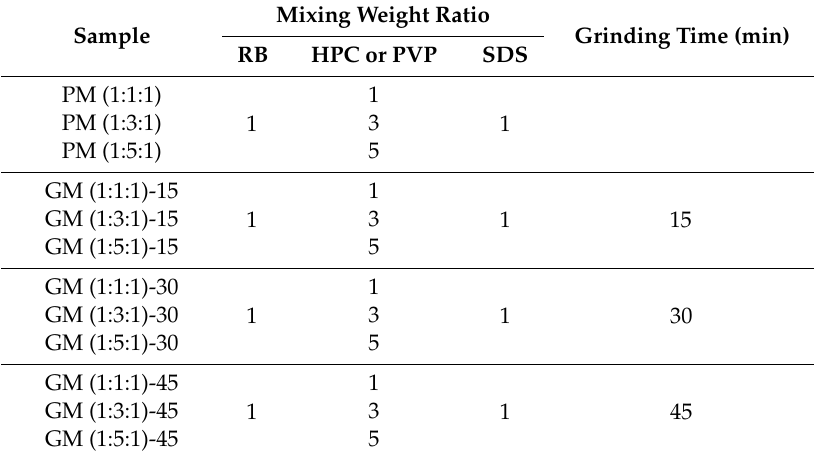
Table 2. Formulation of various samples. PM, physical mixture; GM, ground